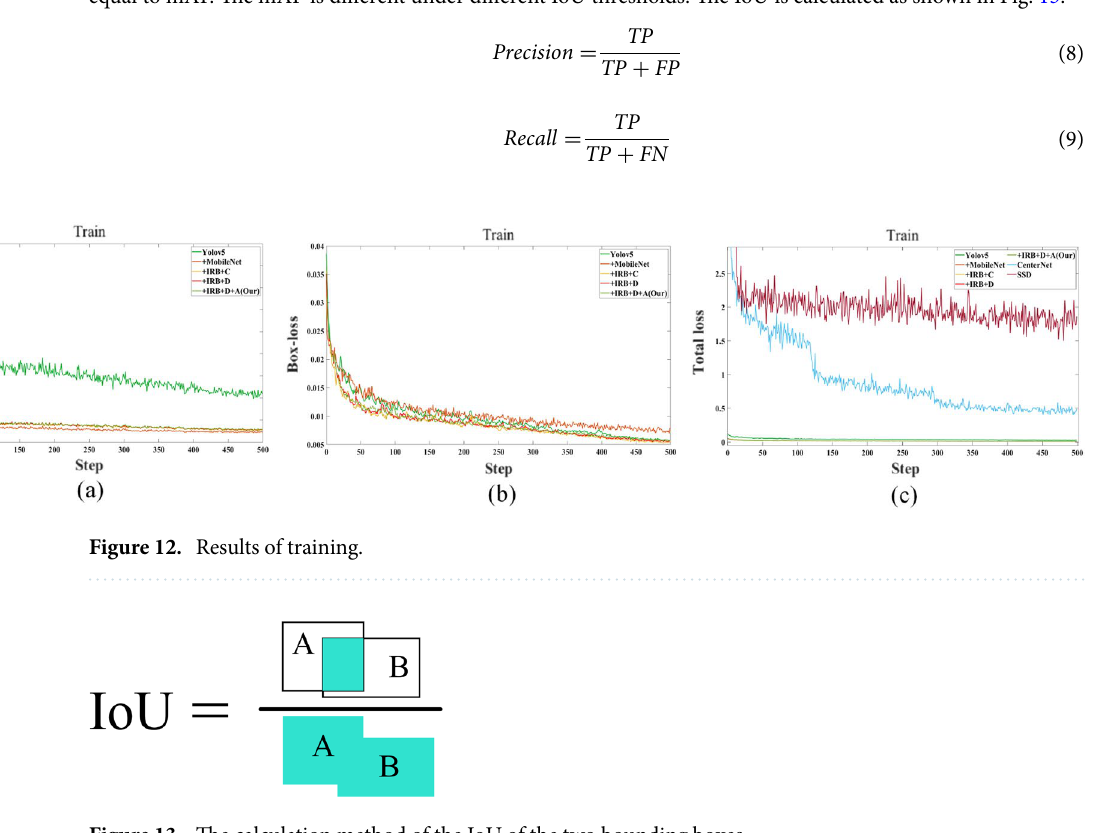
Figure 13. The calculation method of the IoU of the two bounding